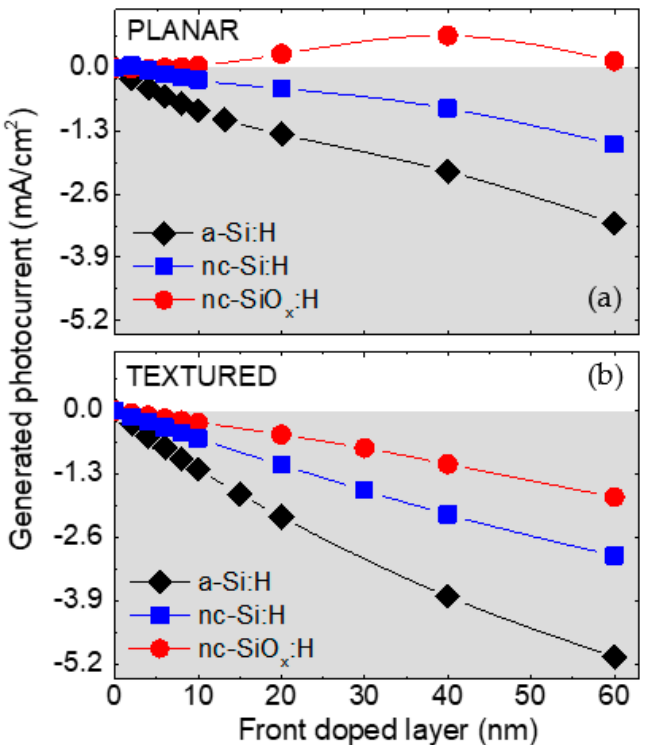
Figure 2. Simulated photocurrent absorbed in the c-Si wafer as a function of front doped layer thickness on ( a ) planar and ( b ) textured morphology. The nc-SiO x :H film used here has a refractive index of 2.7 at 633 nm. The values are reported as a difference relative to the structure with a 0 nm thick front layer. The grey areas indicate current losses. Figure adapted from [47].